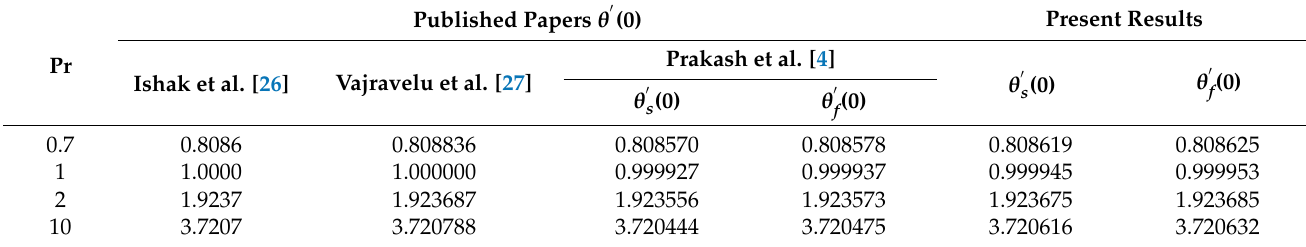
Table 1. Comparison of results for the thermal gradient with published papers for some reduced cases. Published Papers θ (cid:48) (0) Present Results Pr Ishak et al. [26] Vajravelu et al.